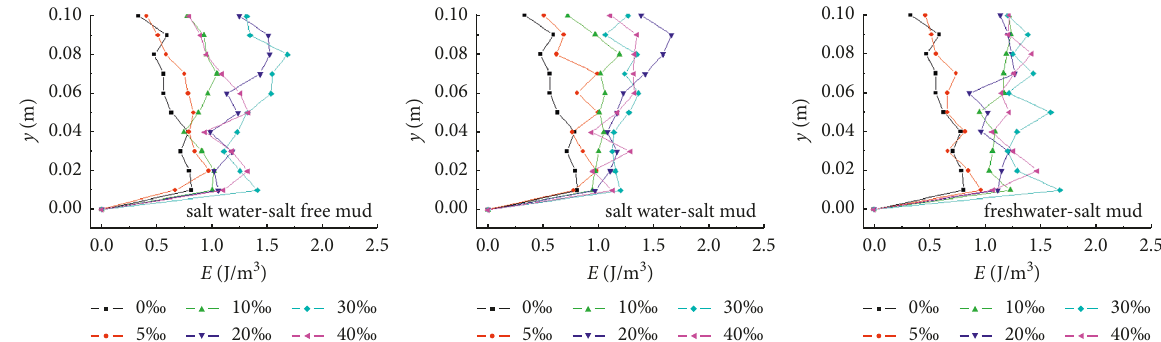
Figure 9: Turbulent kinetic energy of flow under critical condition of the muddy clay